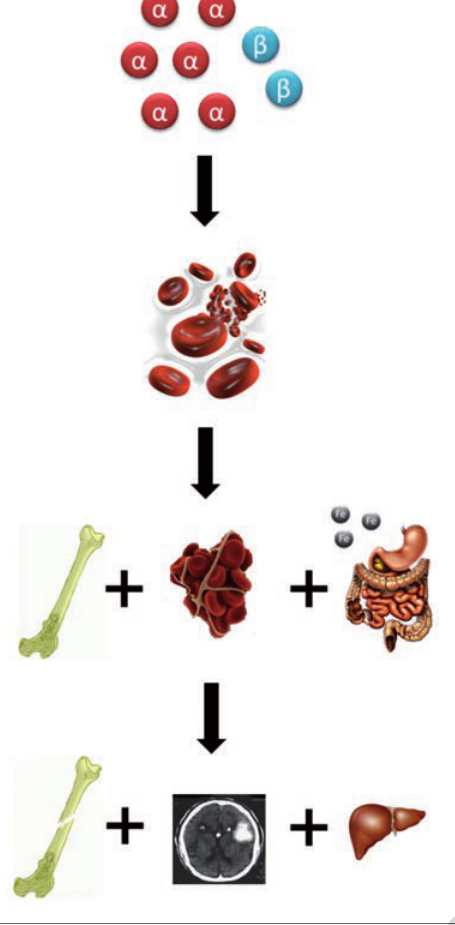
Figure 1. Pathophysiology of thalassemia intermedia in a nutshell. An imbalance in the ration of alpha to non-alpha (beta) chains will lead to cell lysis due to oxidative stress with ensuing chronic hemol- ysis and ineffective erythropoiesis. This leads to bony changes, hypercoagulability, and increased gastrointestinal iron absorption. The end result being osteoporosis and fractures, silent brain infarcts and pulmonary hypertension because of the clots formed, and iron overload manifesting in increased liver iron concentration.